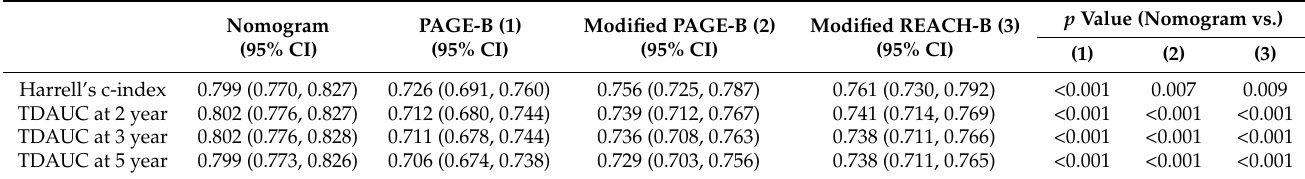
Table 4. Comparison of predictive performance for HCC risk among new nomogram, PAGE-B, modified PAGE-B, and modified REACH-B models in derivation cohort.